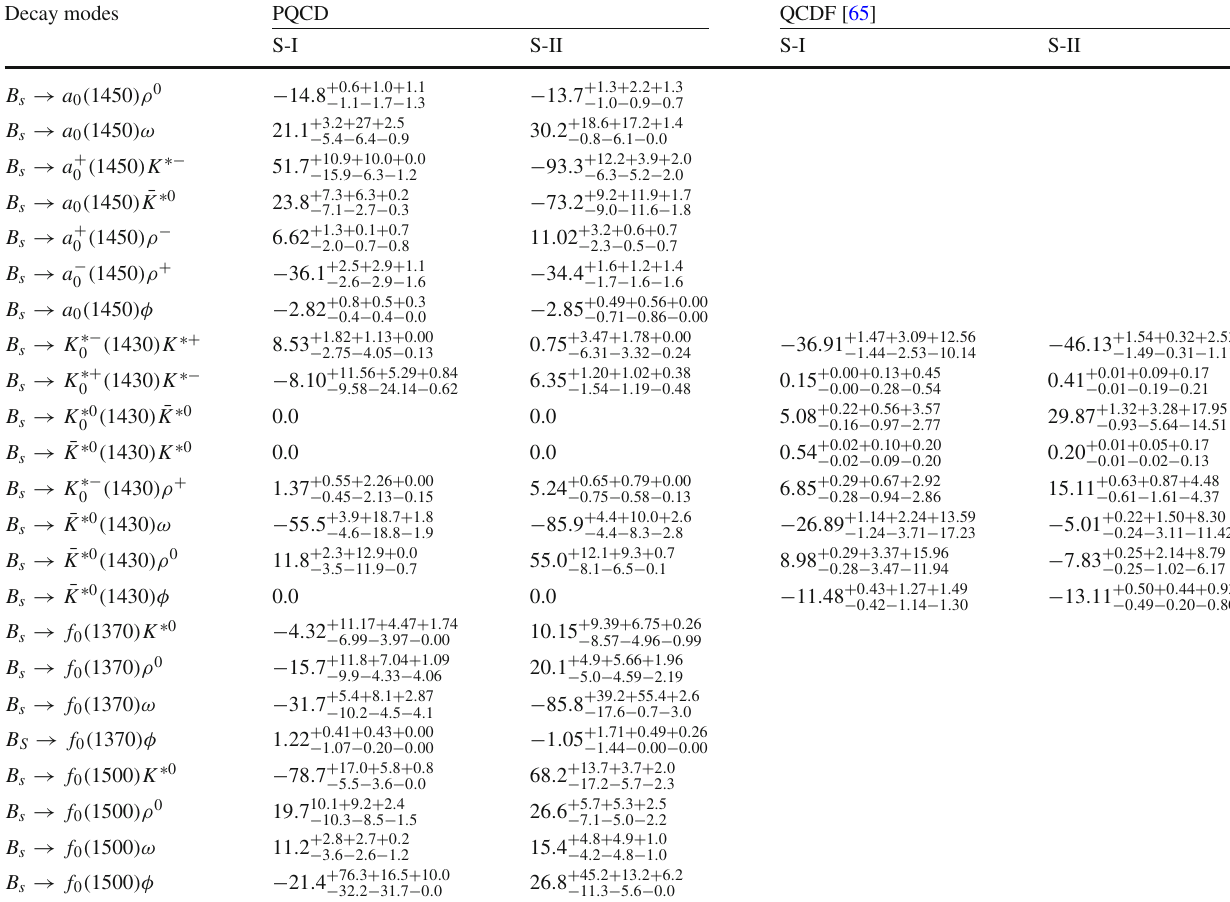
) (in %) of the B s → V S decays involving the heavier scalar mesons in S-I and S-II CP